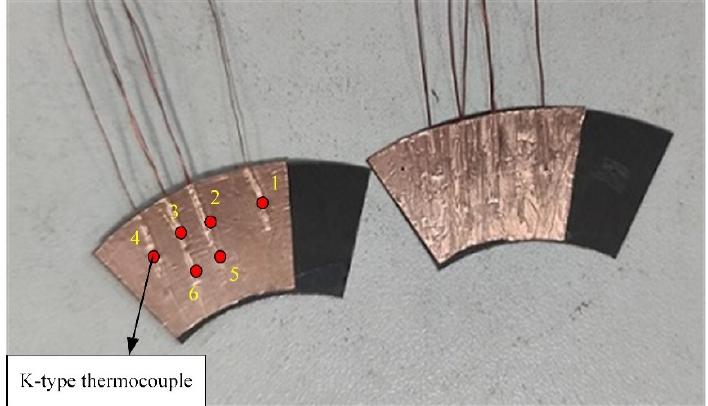
Figure 17. Temperature measuring point bonding.